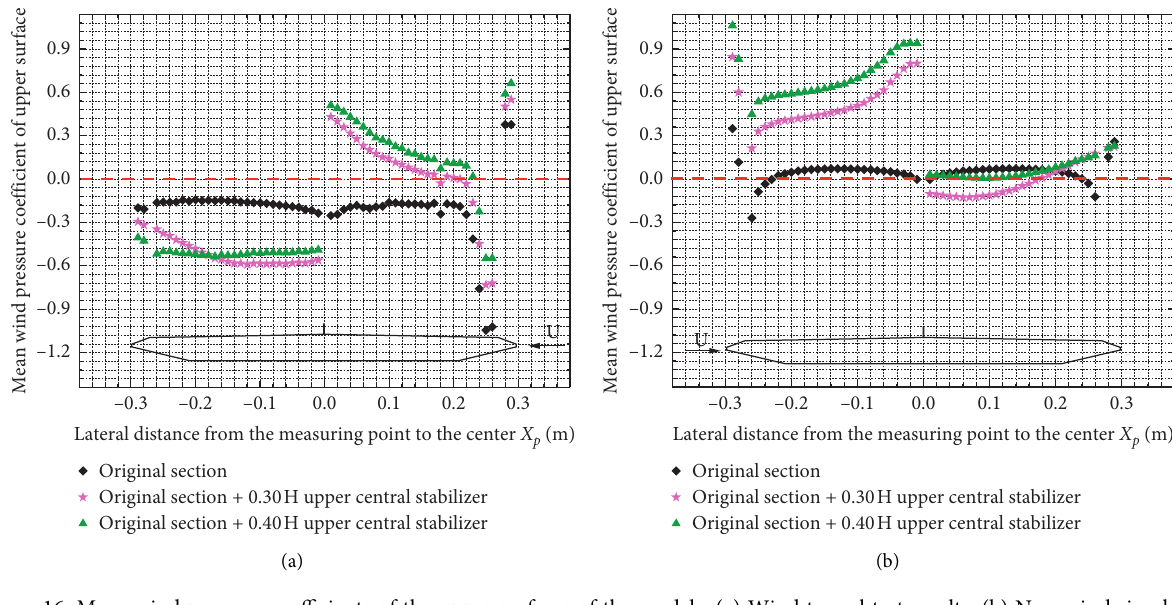
Figure 16: Mean wind pressure coefficients of the upper surfaces of the models. (a) Wind tunnel test results. (b) Numerical simulation results.